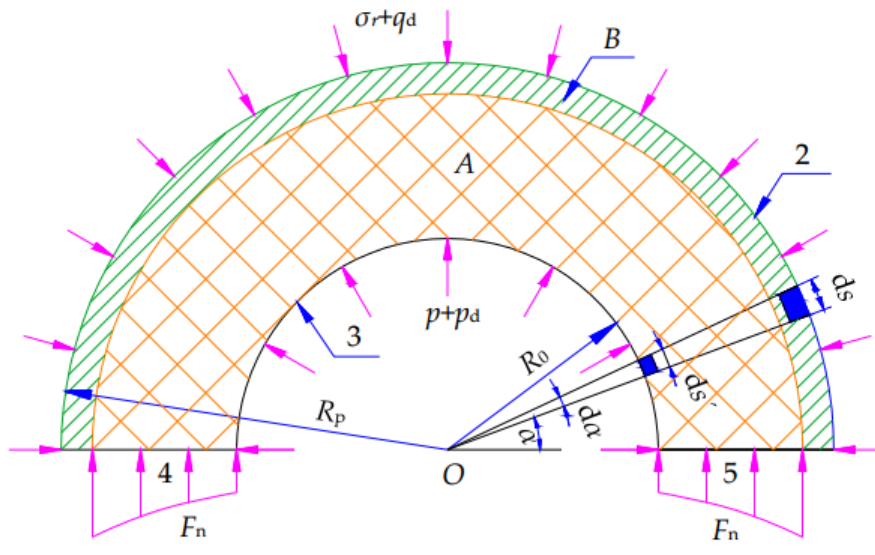
Figure 5. Impact resisting model for the anchoring structure.